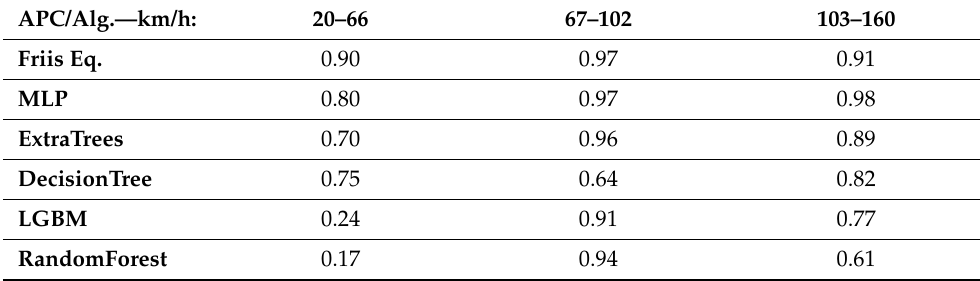
Table 4. The 3-classes—classifiers ranking. Total APC per class and Friis equation total APC . APC/Alg.—km/h: